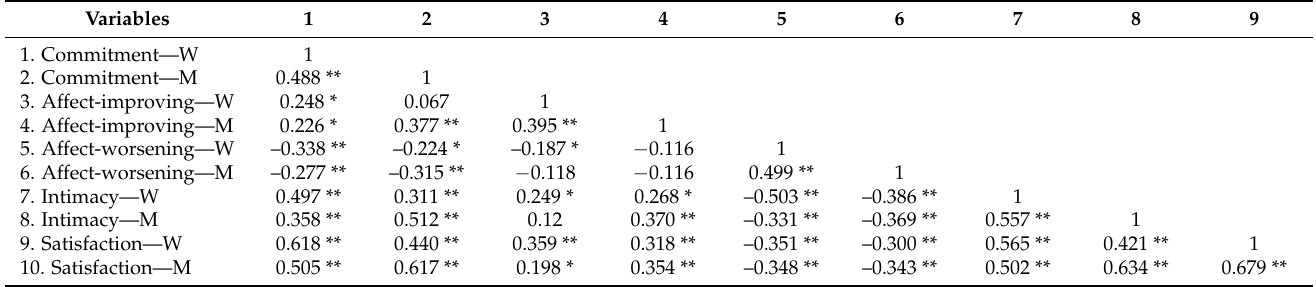
Table 2. Zero-order correlations for the main variables of the study by